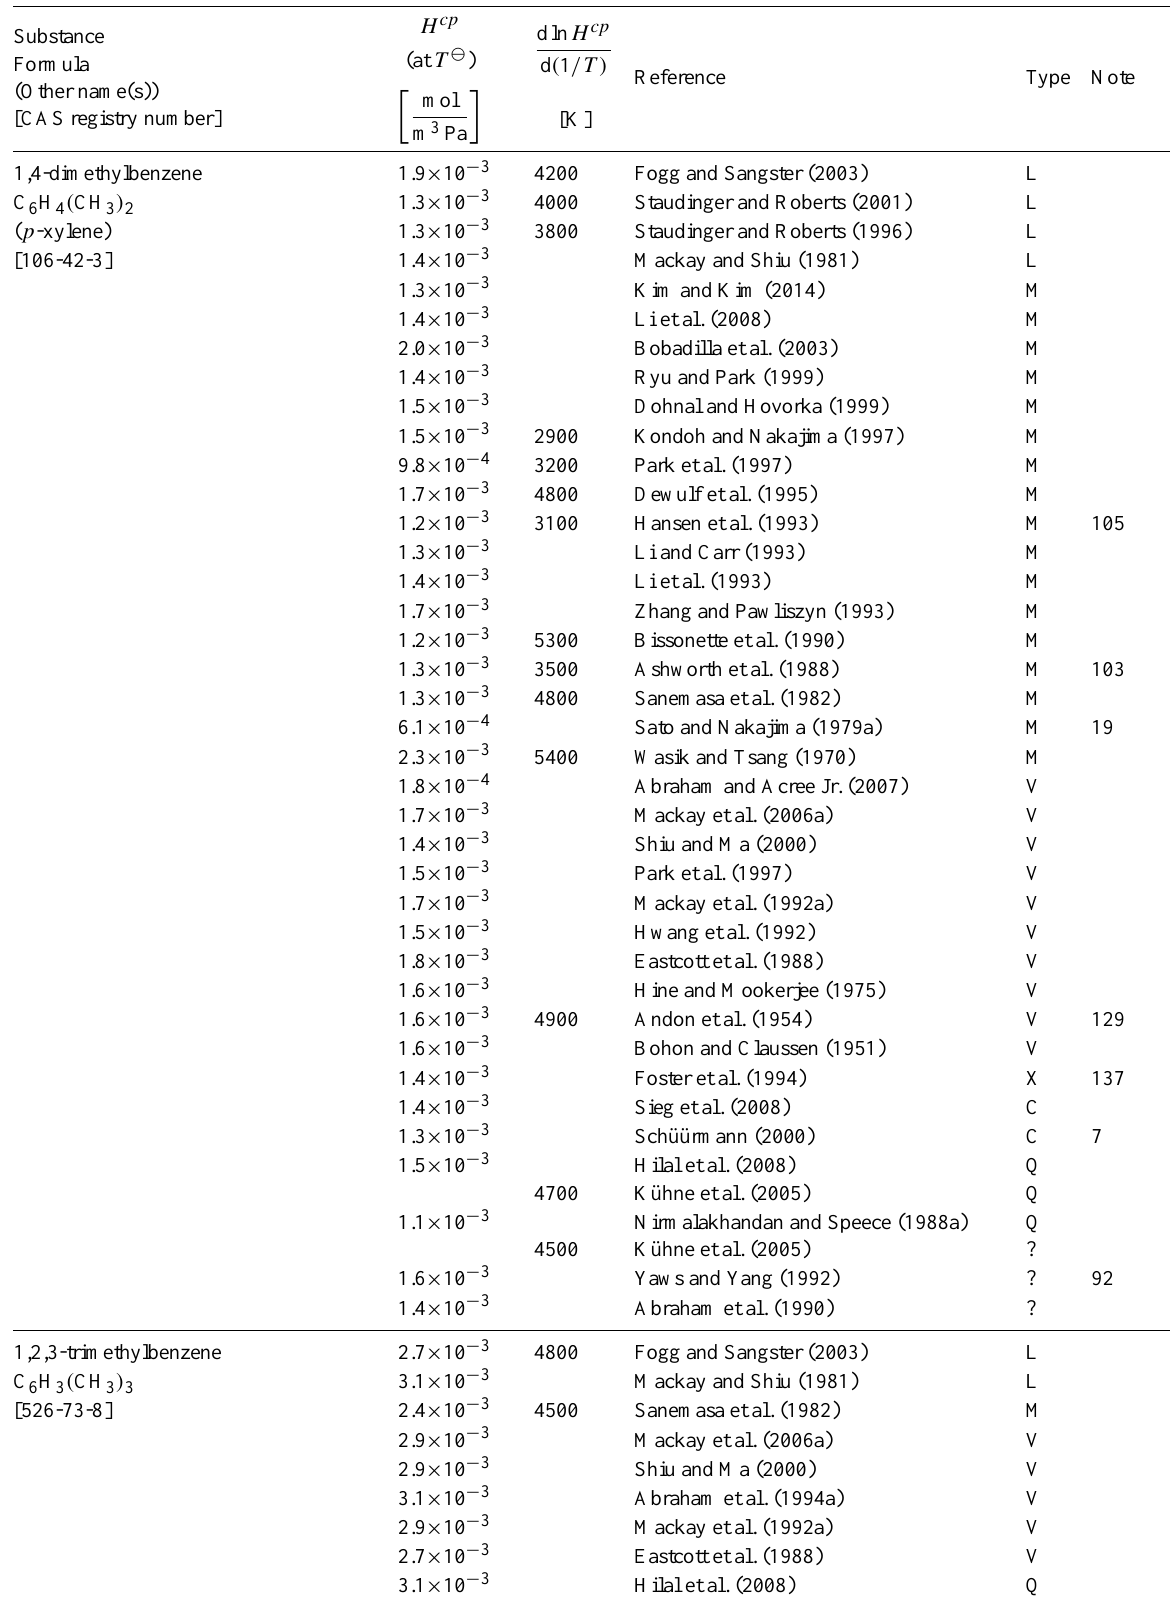
Table 6: Henry’s law constants for water as solvent